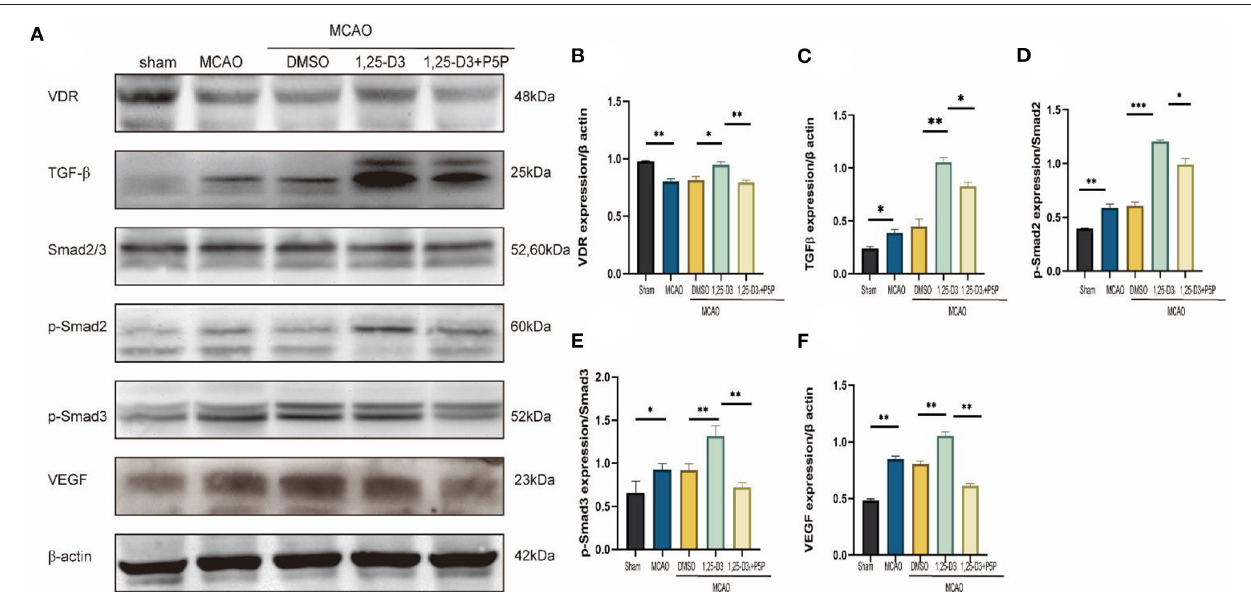
FIGURE 6 | 1,25-D3 promoted the expression of VDR, TGF- β , p-Smad2, p-Smad3, and VEGF induced by cerebral ischemic reperfusion 3 days after MCAO. (A) Western blot showed the expression of VDR, TGF- β , Smad2/3, p-Smad2, p-Smad3, VEGF in the ischemic penumbra cortex. Quantification of VDR (B) , TGF- β (C) ,